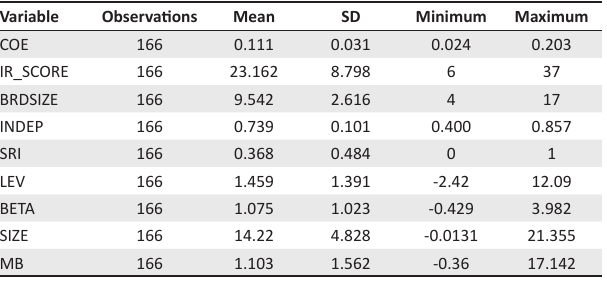
TABLE 1: Descriptive statistics: Cost of equity.